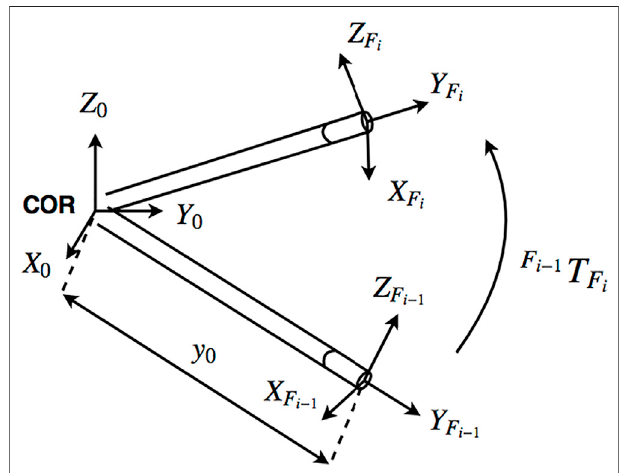
FIGURE 8 | Reference frames at the center of rotation and tool tip (Gautier et al., 2019).